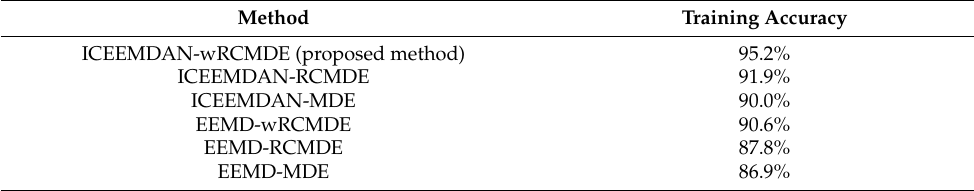
Table 3. Training accuracy of different